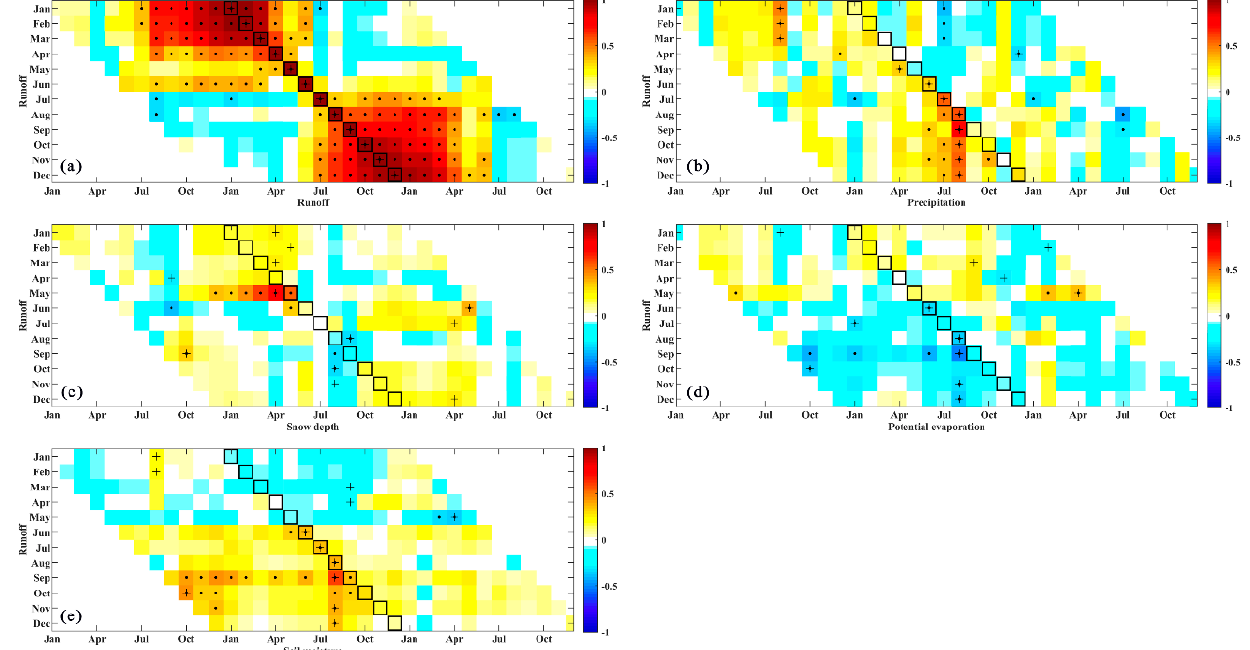
Figure 4. Lead and lag correlation between runoff at Shigu station and impact factors in the upper Jinsha River (( a ): runoff autocorrelation; ( b ): correlation of runoff and precipitation; ( c ): correlation of runoff and snow depth; ( d ): correlation of runoff and potential evaporation; ( e ): correlation of runoff and soil moisture. box represents contemporaneous correlation, + represents the month with maximum correlation, · represents 0.01 confidence